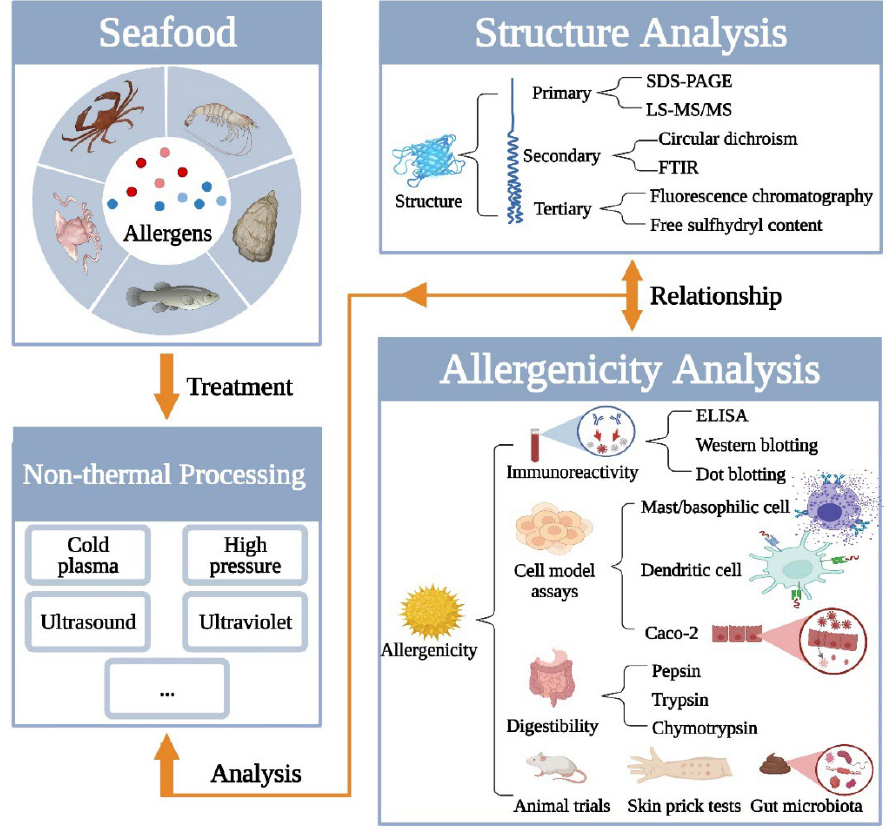
Figure 1. Analysis for structure and allergenicity changes of seafood allergens induced by non-thermal processing.